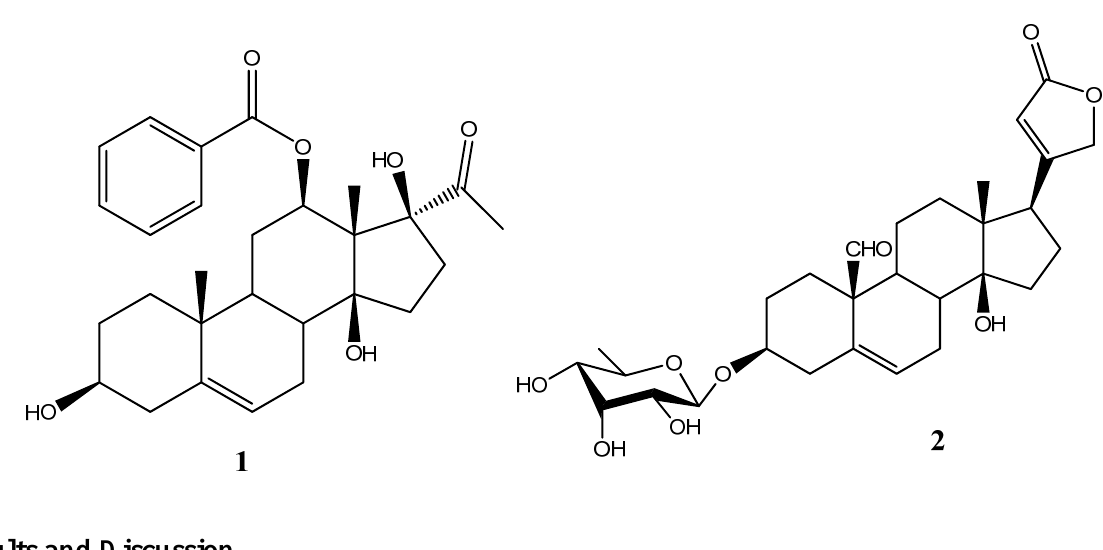
Figure 1. Structures of Compounds 1 and 2